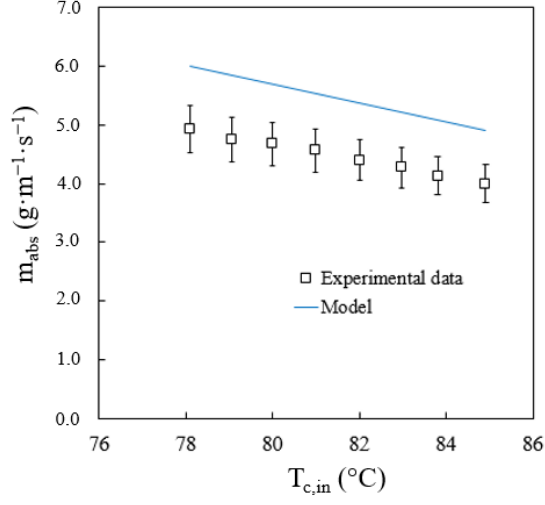
Figure 10. Effect of cooling water temperature on the vapour absorption rate.